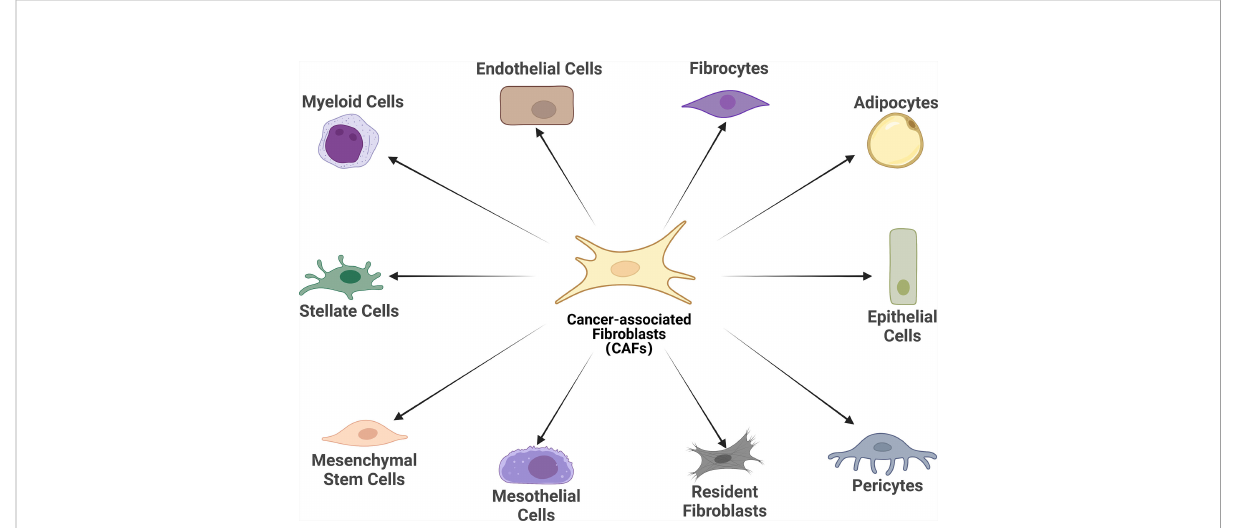
FIGURE 1 Cell of origin of cancer-associated fi broblasts (CAFs). Schematic representation of the cells of origin of CAFs that have been reported or in potential, including epithelial cells, mesothelial cells, resident fi broblasts, stellate cells, pericytes, adipocytes, mesenchymal stem cells, myeloid cells, fi brocytes, and endothelial